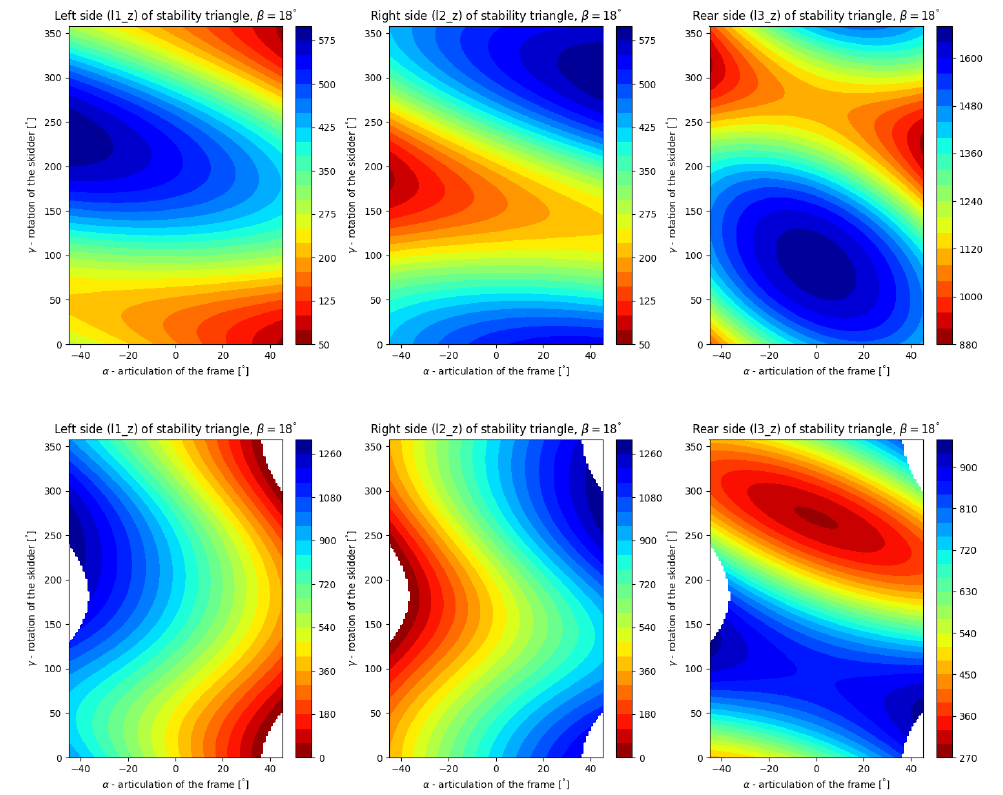
Figure 7. Comparison of firefighting devices stability. Upper plots are valid for an unloaded skidder (C1 config.), lower ones for C2 config.—full, 2000 L water tank behind the rear axle